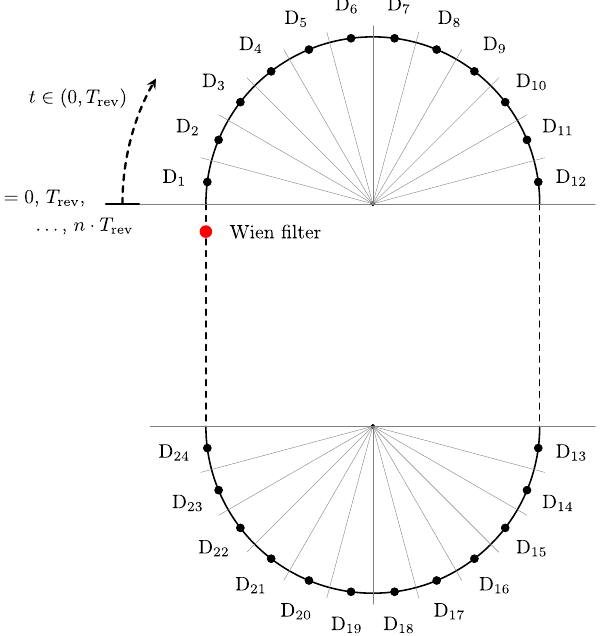
FIG. 4. Sequence of elements in the ring, corresponding to Eq. (42). The D ( i ¼ 1 ; … ; 24 ) indicate the 24 dipole magnets of i COSY. The counting of t begins with one turn in the ring, and, as indicated, the Wien filter is passed at the end of each revolution. For the discussion presented here, the dashed lines have zero